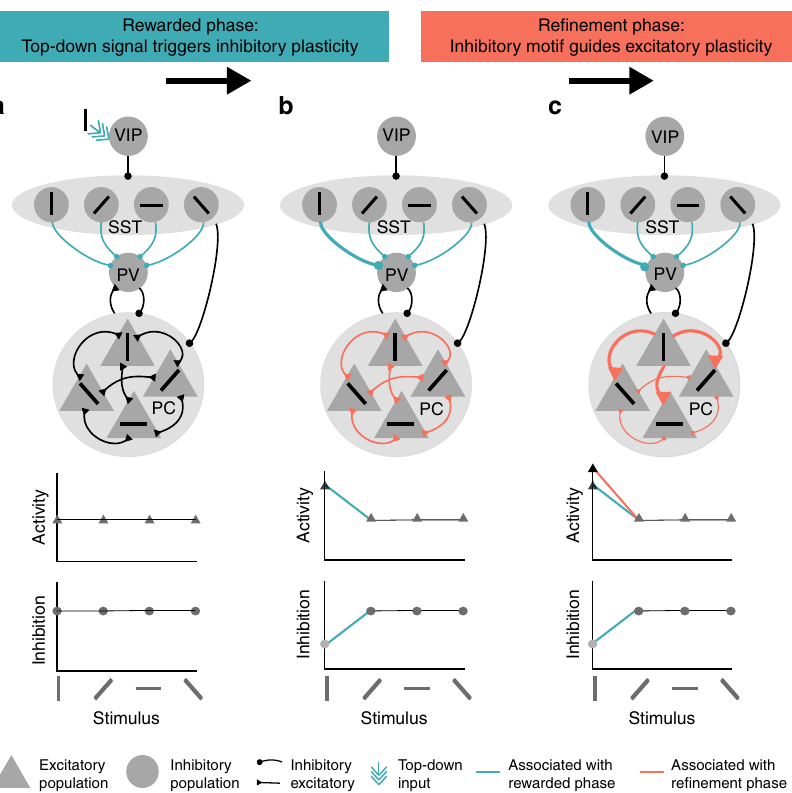
Fig. 1 The two-stage model of top-down guided plasticity. a Before the rewarded phase. We assume the SSTs and PCs to be stimulus-tuned and PVs to be untuned. During the rewarded phase, the top-down signal activates VIPs when the rewarded stimulus is present (vertical bar). This triggers plasticity at the SST-to-PV connections. b At the end of the rewarded phase and at the beginning of the re fi nement phase, there are strong connections from the SSTs tuned to the vertical bar to PVs (green, top). The PV activity is therefore low for the vertical bar (bottom). The excitatory neurons coding for the vertical bar are disinhibited (middle). During the re fi nement phase, the inhibitory motif guides plasticity at the excitatory neurons. c At the end of the re fi nement phase, strong connections from the excitatory neurons coding for the vertical bar to the other excitatory neurons have developed (red, top). This results in an increased activity of excitatory neurons towards the vertical bar (red line, middle) beyond that resulting from reduced inhibitory PV activity (blue line, middle, and bottom). Note that existing connections between cell types are omitted in the fi gure to increase